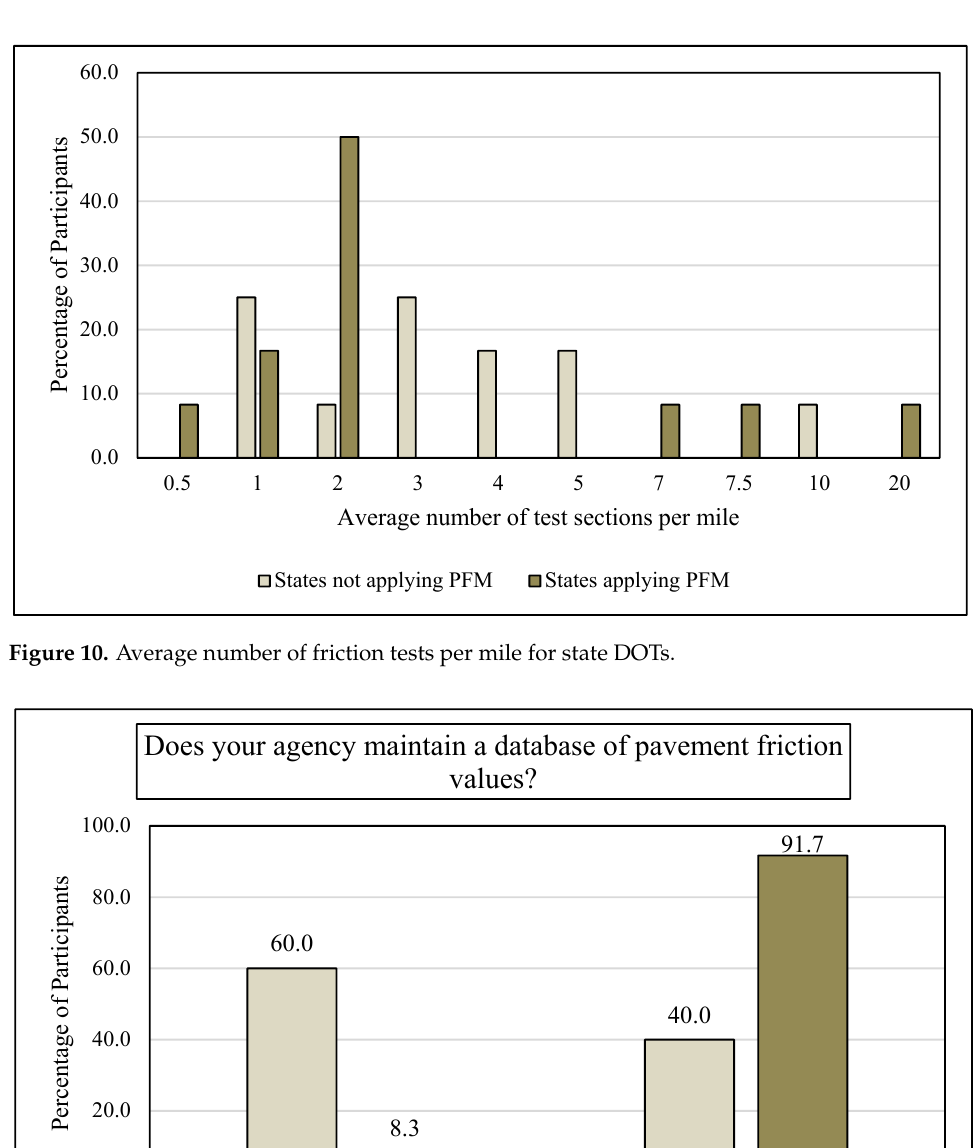
555 Table 6. Correlation results between the policy of applying PFM and related practices. Variable 1